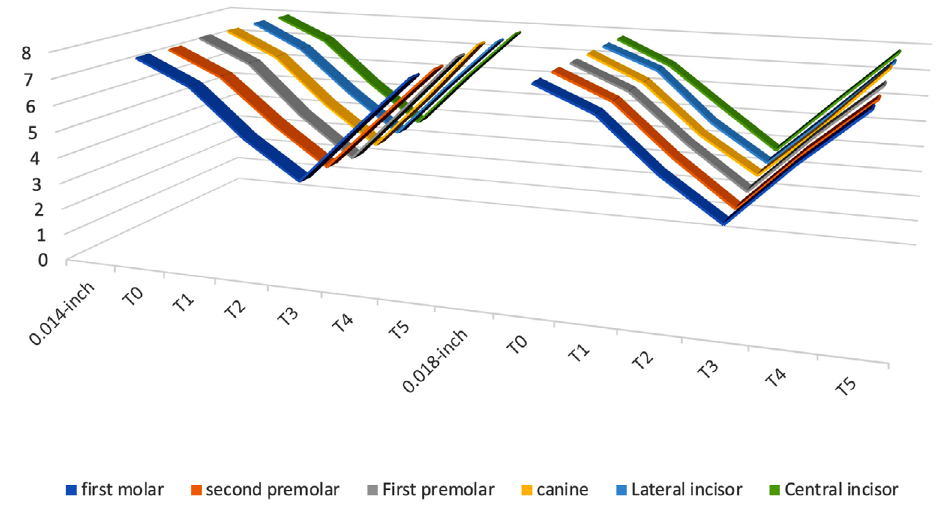
Figure 3- PBF changes in 0.018-inch NiTi archwire compared to 0.014-inch NiTi archwire